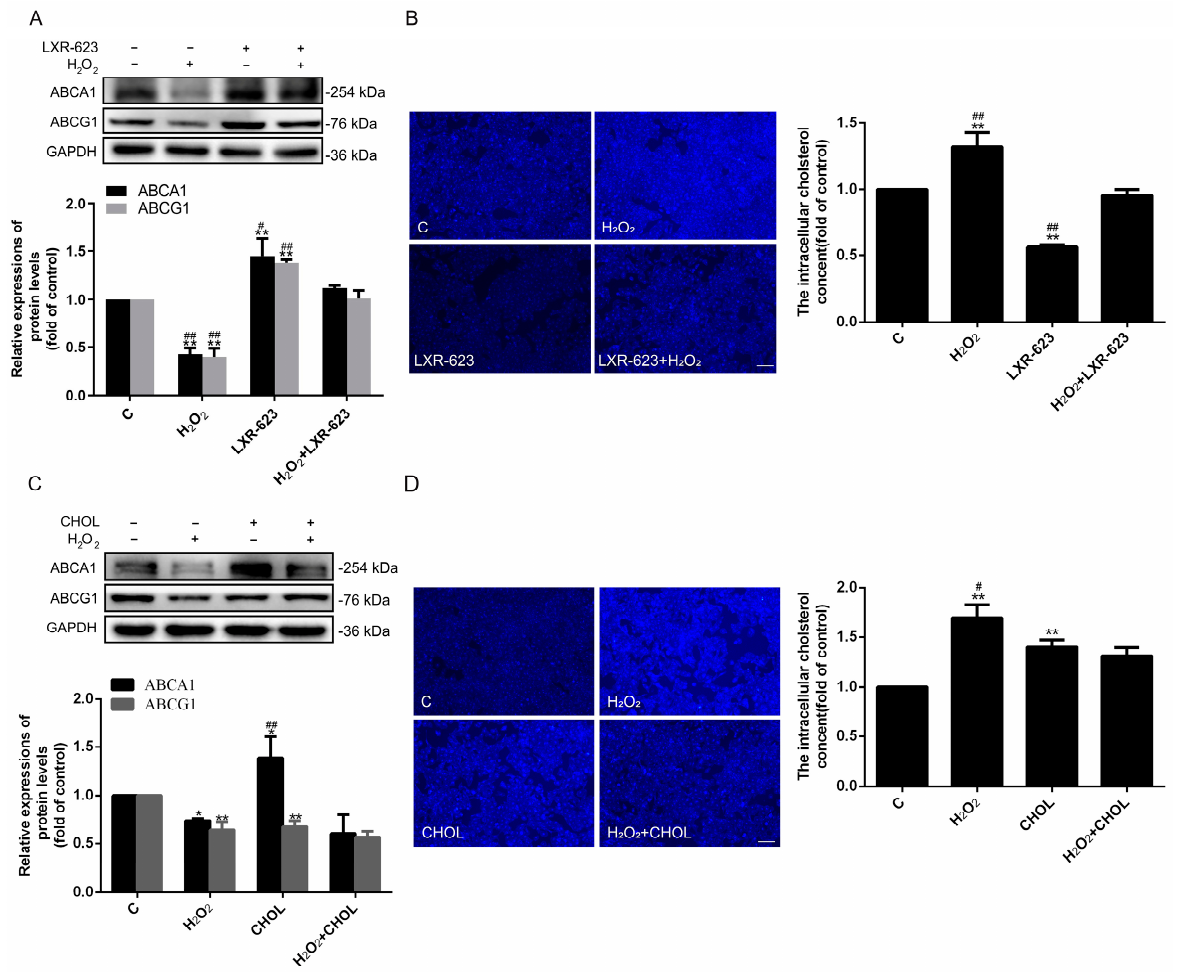
Figure 2. LXR-623 can promote cholesterol efflux, and adding cholesterol extracellularly can induce cholesterol accumulation. ( A , C ) The expressions of ABCA1 and ABCG1 were detected by Western blot. ( B , D ) Filipin staining detected the intracellular cholesterol of HUVECs (magnification 5 × ). n = 3, * p < 0.05, and ** p < 0.001 vs. the C group; # p < 0.05, and ## p < 0.001 vs. the H 2 O 2 + LXR-623 group; # p < 0.05, and ## p < 0.001 vs. the H 2 O 2 + CHOL group. The C (control) group of LXR-623 and cholesterol were treated by DMSO and chloroform, respectively; H 2 O 2 , cells treated with H 2 O 2 (500 µ mol/L) for 24 h; LXR-623, cells treated with LXR-623 (5 µ mol/L) for 24 h; H 2 O 2 + LXR-623, cells treated with LXR-623 (5 µ mol/L) for 2 h and then treated with H 2 O 2 (500 µ mol/L) for 22 h; CHOL, cells were treated by cholesterol (100 µ mol/L) for 24 h; H 2 O 2 + CHOL, cells were firstly treated by cholesterol (100 µ mol/L) for 2 h, and then H 2 O 2 (500 µ mol/L) was used to treat cells for 22 h. The scale of the images is 100 µm.